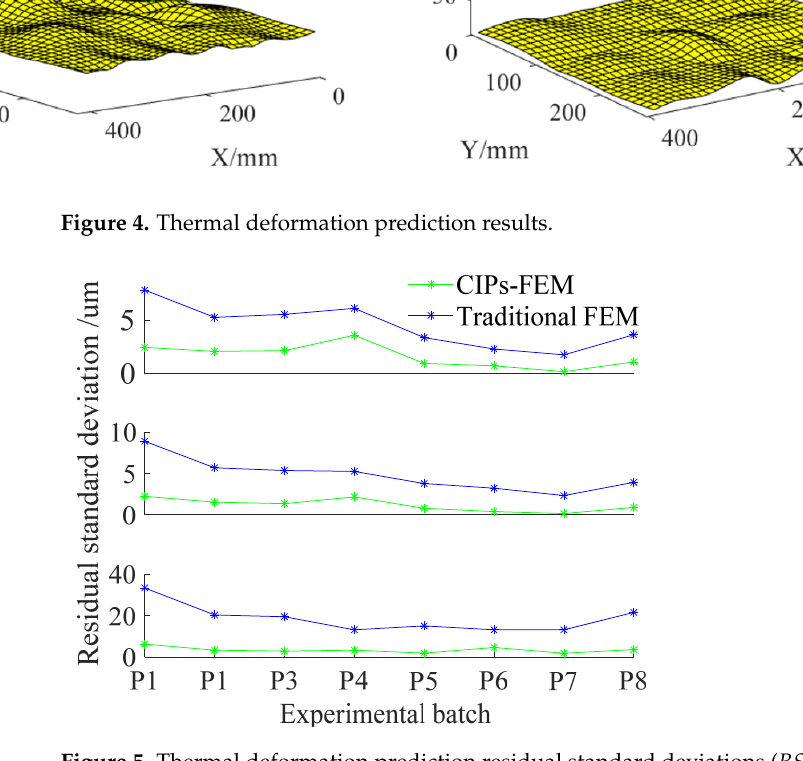
Figure 5. Thermal deformation prediction residual standard deviations ( RSDs ) of P1–P8.